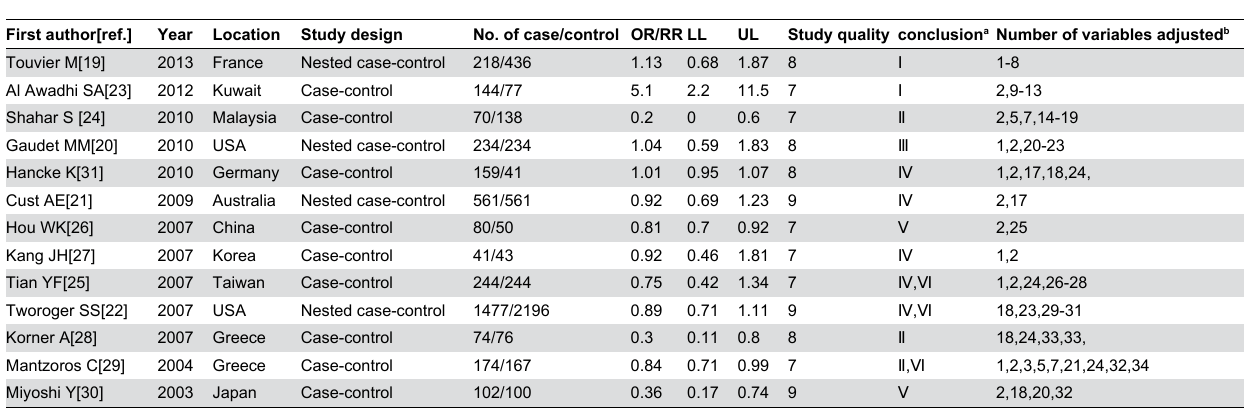
Table 1. Characteristics of studies included in the OR meta-analysis.